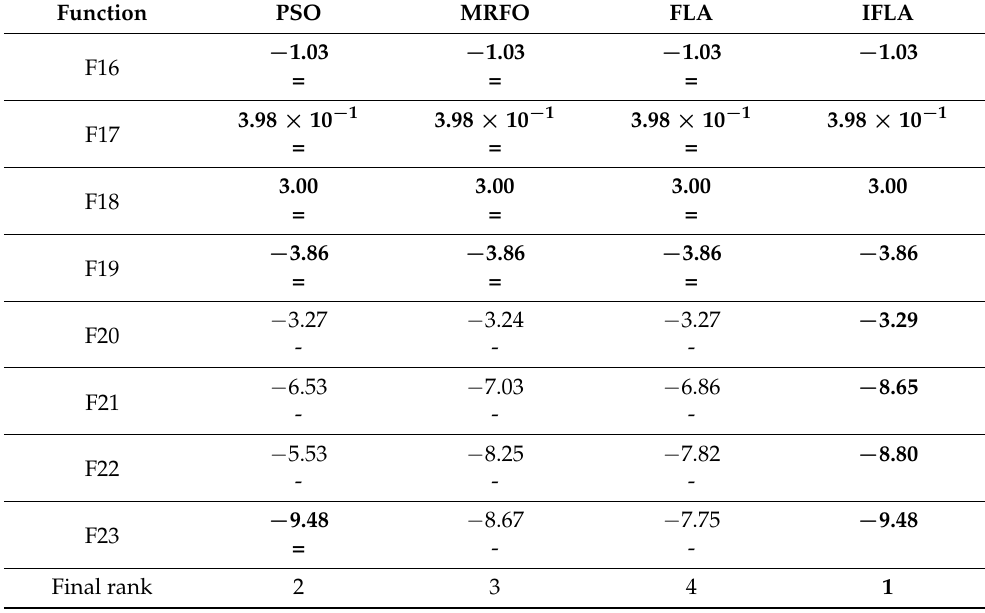
Table 2. Cont . Function